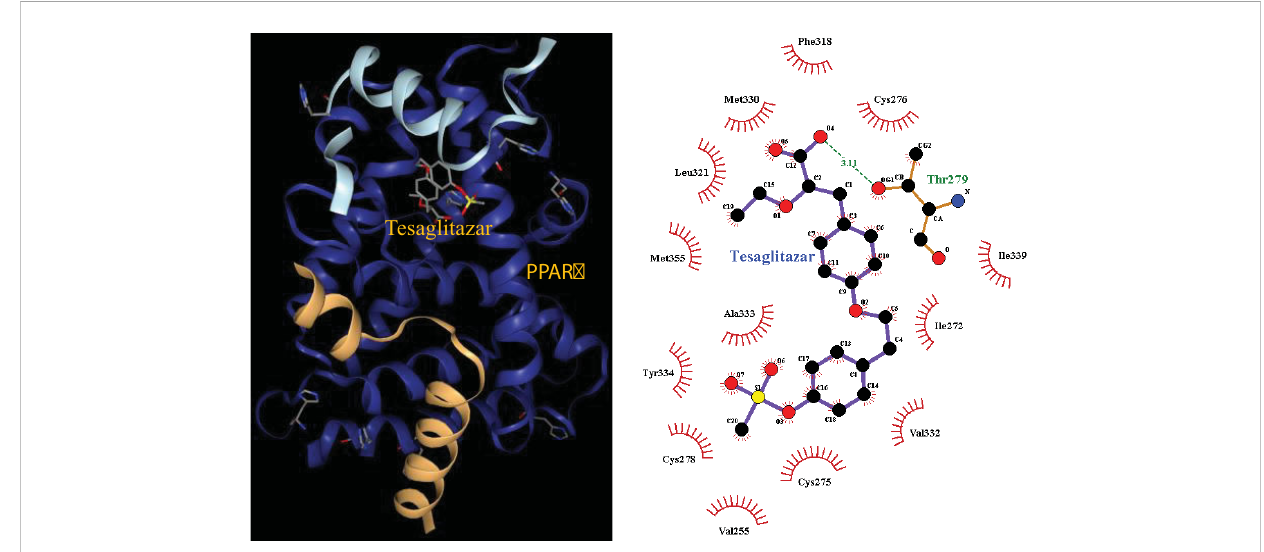
FIGURE 9 Molecular docking 3D map of PPAR ɑ ligand-binding domain with Tesaglitazar and 2D pose view of ligand and receptor